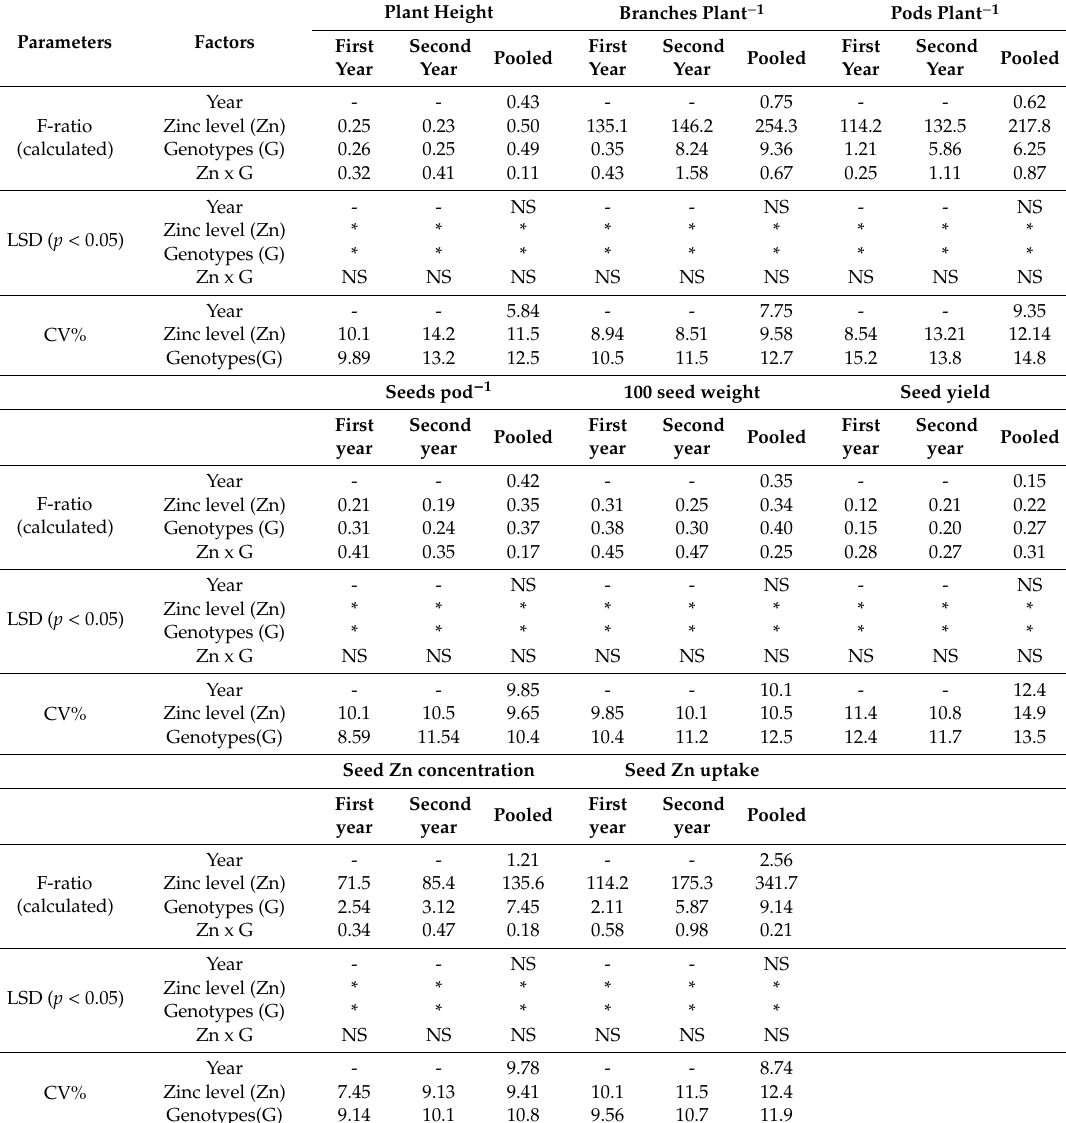
Table 1. Analyses of variance for plant height (m), branches plant − 1 , pods plant − 1 , seeds pod − 1 , 100 seed weight (g), seed yield (t ha − 1 ), seed zinc (Zn) concentration (mg kg − 1 ), and seed Zn uptake (g ha − 1 ) of pigeonpea genotypes for two years separately and pooled. F-ratio indicates ratio of two variances, LSD = least significant di ff erence, CV = coe ffi cient of variation, NS = not significant at p < 0.05, * = significant at p <